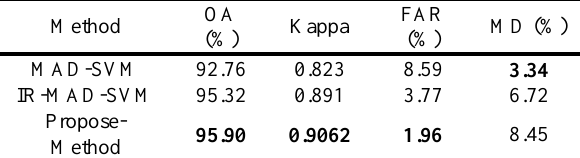
Table 3. The result of HCD for the China Dataset.